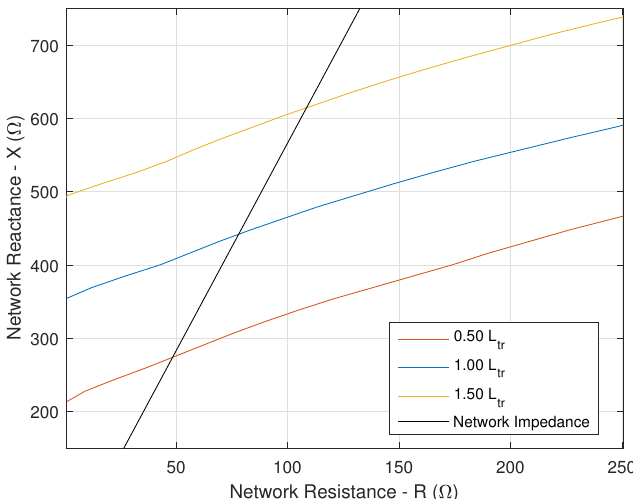
Figure 15. Stability limit curve of a traction chain in the network reactance ( X ) and resistant ( R ) complex plane. Variation of leakage inductance while keeping the current controller bandwidth at 100